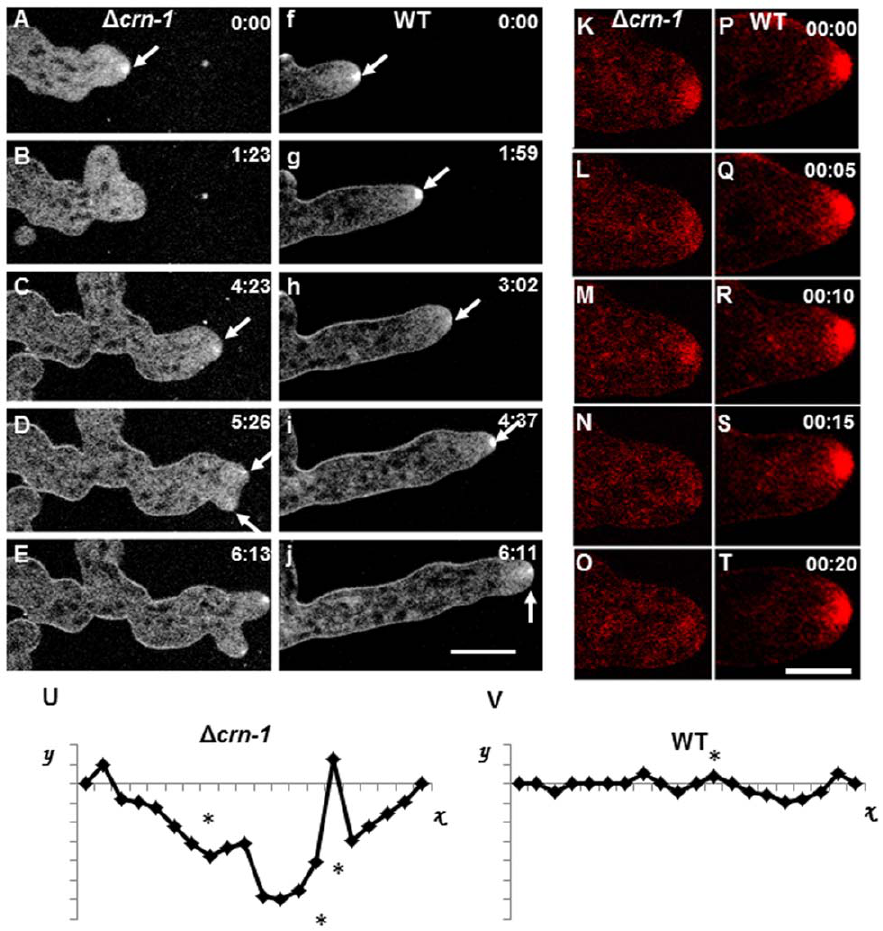
Figure 7. Comparative morphogenesis and Spk behavior revealed by staining hyphae with FM4-64. (A–E) D crn-1 mutant and (F–J) WT strain. Arrows show the Spk. Details of Spk dynamics in (K–O) D crn-1 mutant and (P–S) WT strain. Spk trajectories plotted relative to the growth axis (abscissa). Time in min:sec. Scale bar=10 m m.